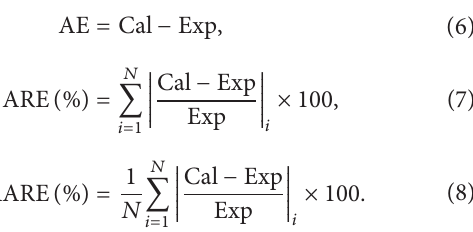
which are very close to the experimental